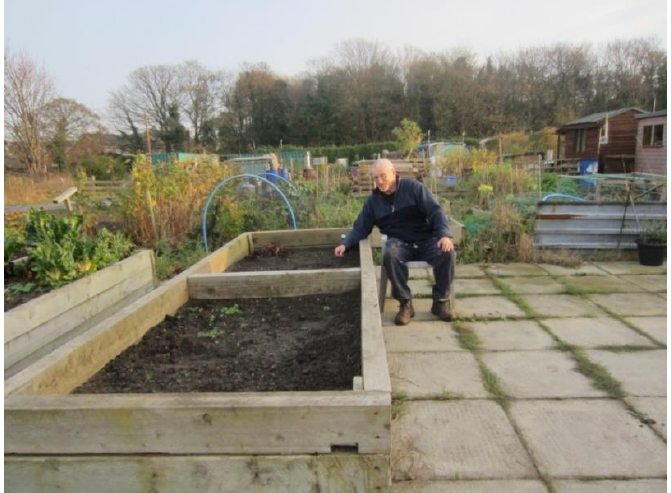
Figure 17. Example of allotments promoting respect and social inclusion (P9) (Allotment in Mersey Road, Liverpool).